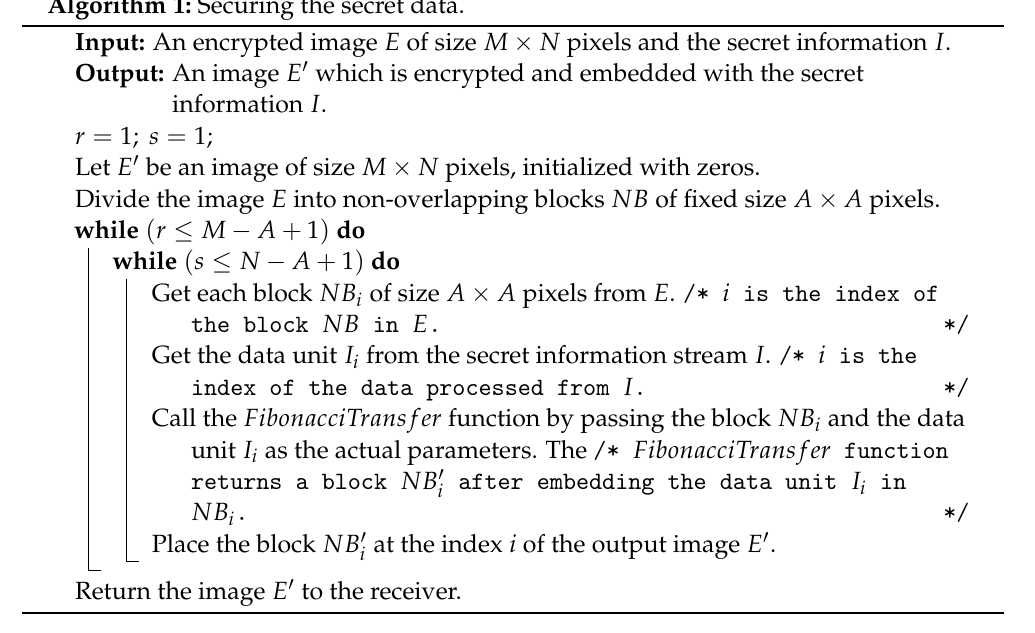
Algorithm 1: Securing the secret